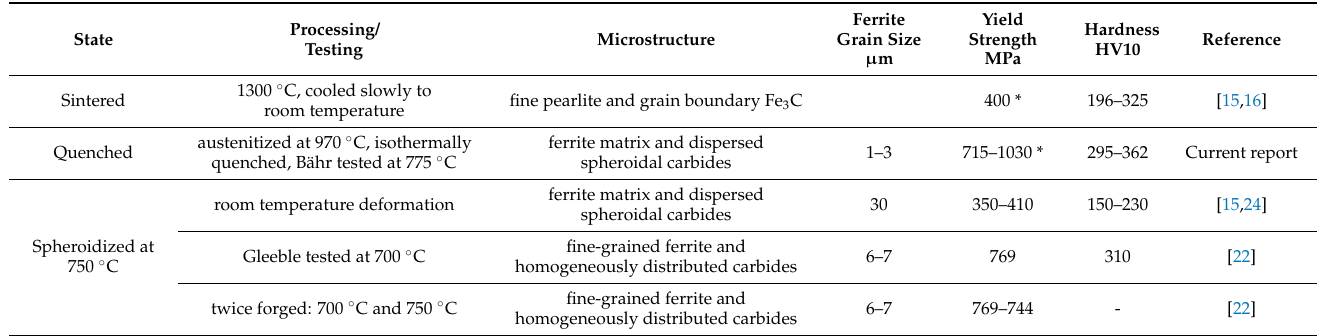
Table 4. Microstructure, yield strength, and hardness of Fe-0.85Mo-0.65Si-1.4C.